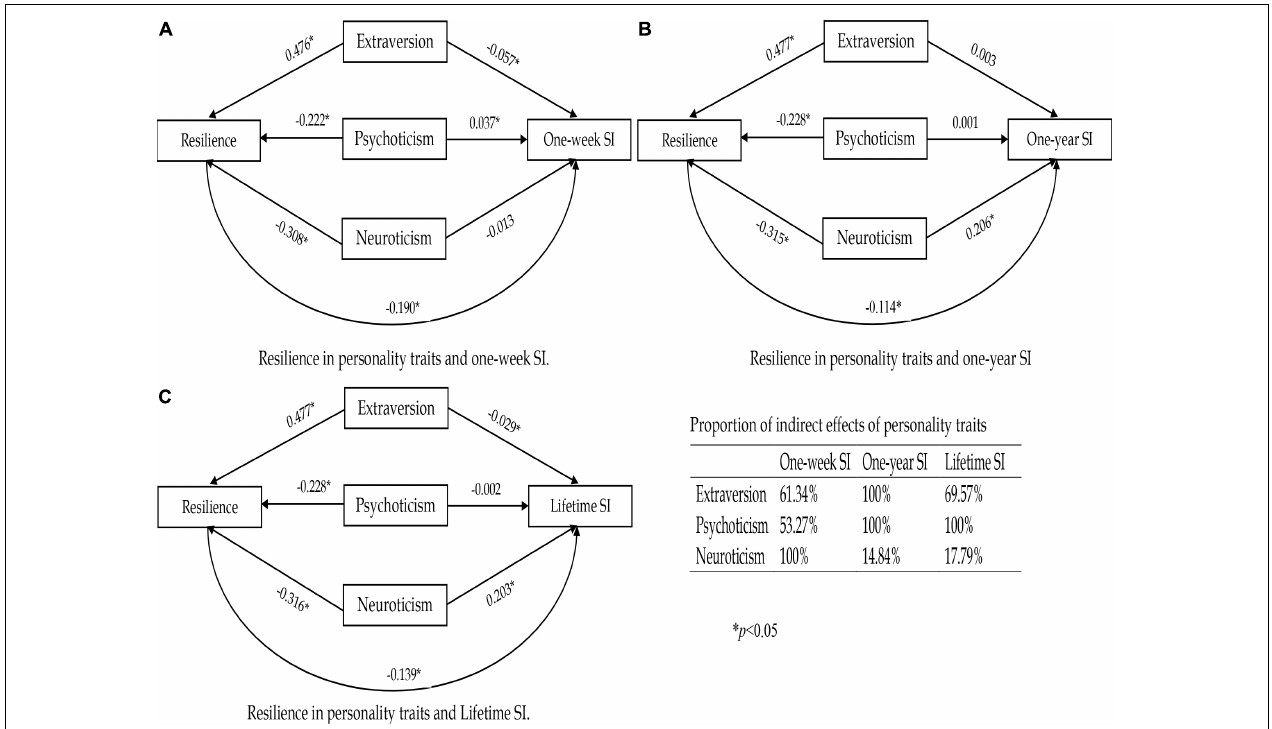
FIGURE 1 | Path models indicating the mediation of resilience in the associations between dimensions of personality traits and SI. (A–C) Represent 1-week SI, 1-year SI, and lifetime SI, respectively.